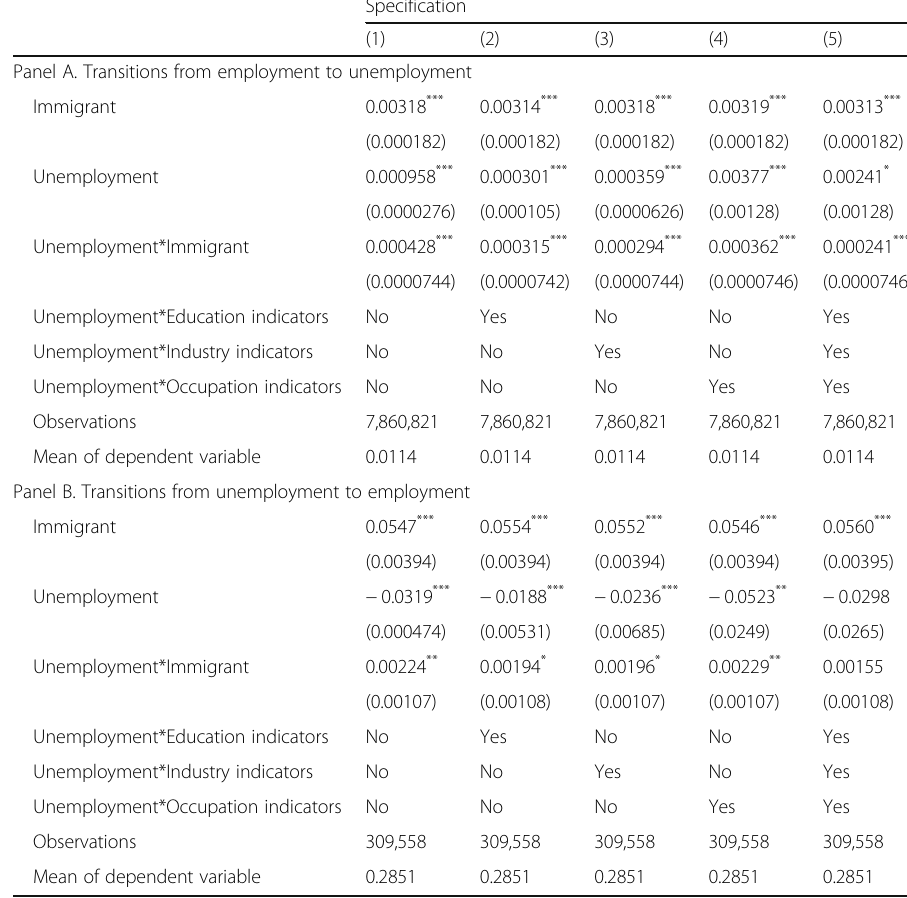
Table 15 Tests for the influence of education, occupation, and industry based on two-way transitions: matched CPS data, 1996 –